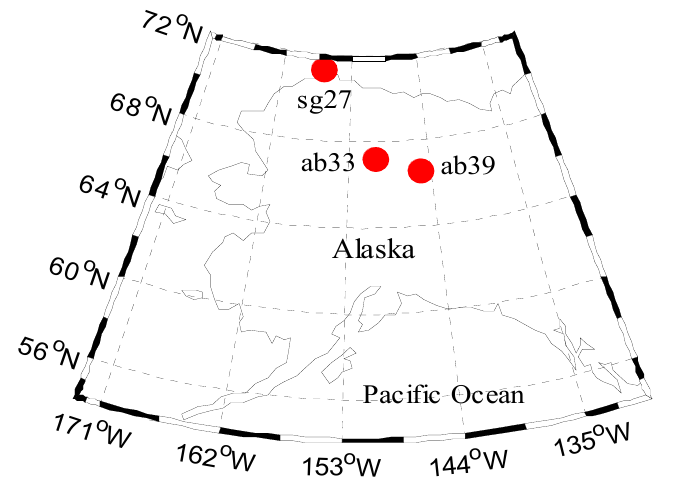
Figure 1. Location of GPS stations in Alaska.